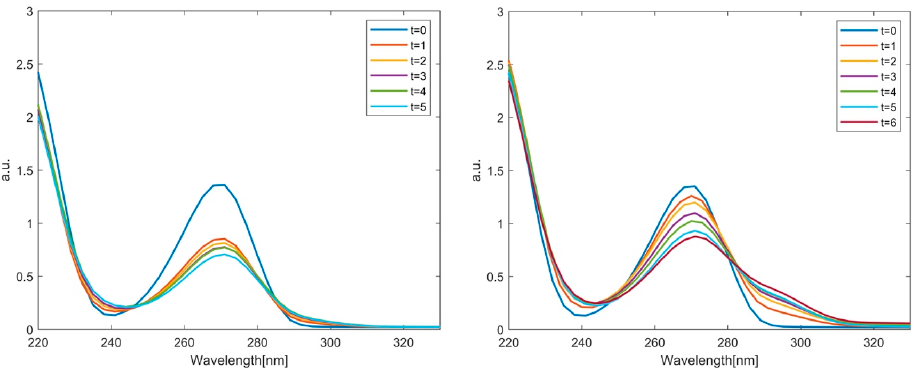
Figure 10. From left to right, UV–Vis spectra of phenol photodegradation over time for AC–TiO 2 and TiO 2 .